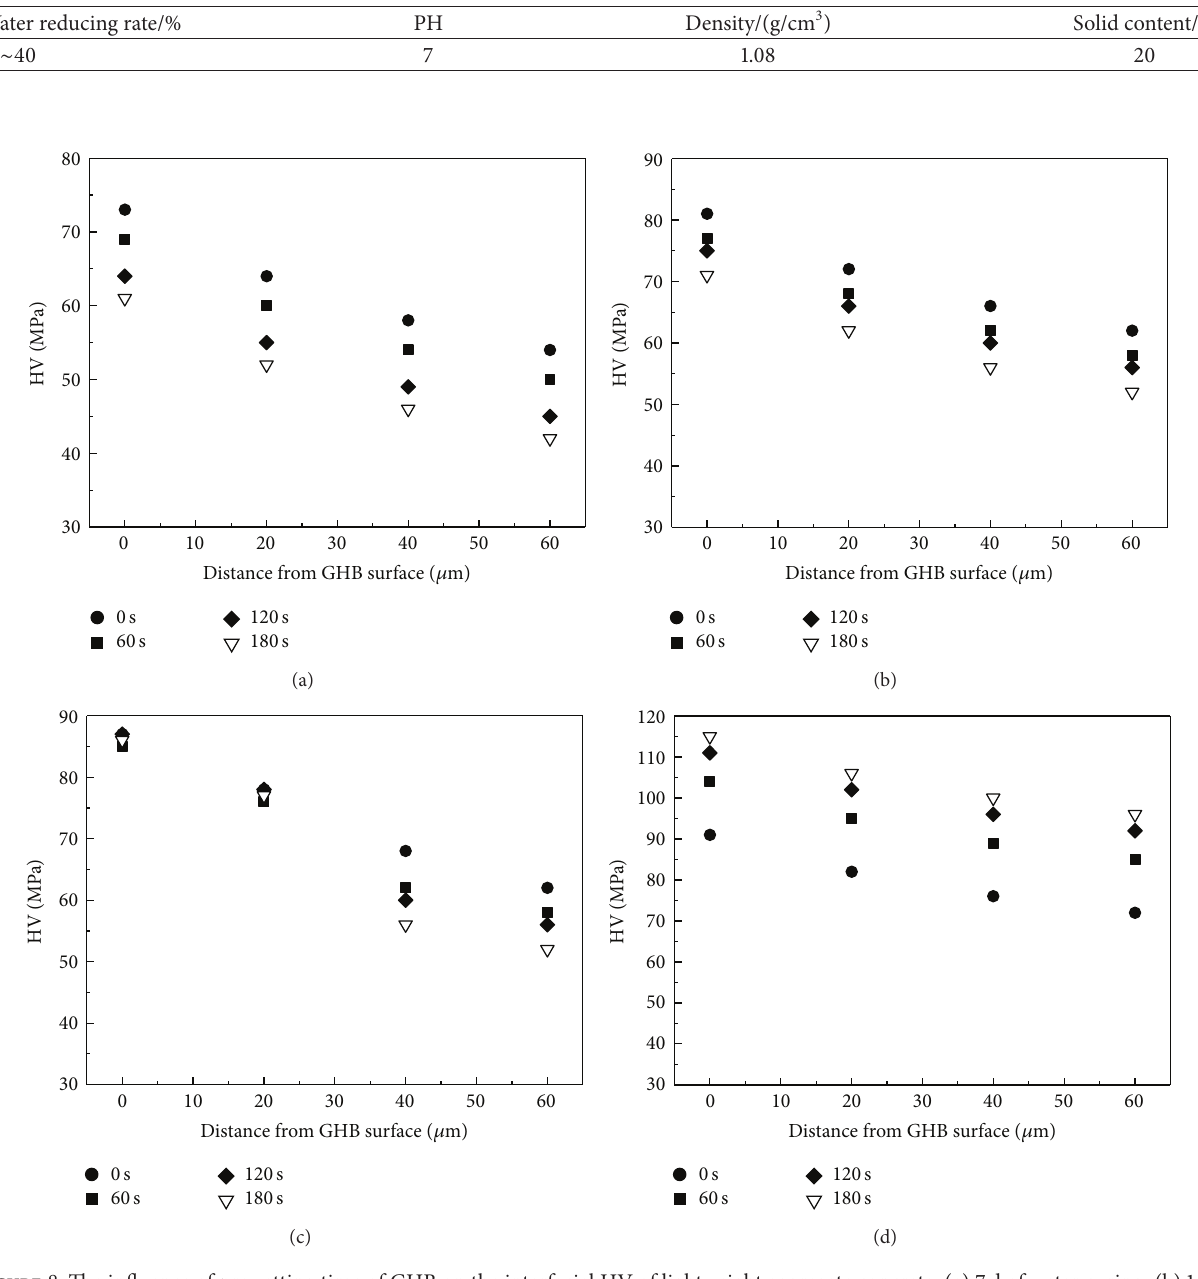
Figure 8: The influence of prewetting time of GHB on the interfacial HV of lightweight aggregate concrete: (a) 7d of water curing, (b) 14d of water curing, (c) 28d of water curing, and (d) 56 d of water